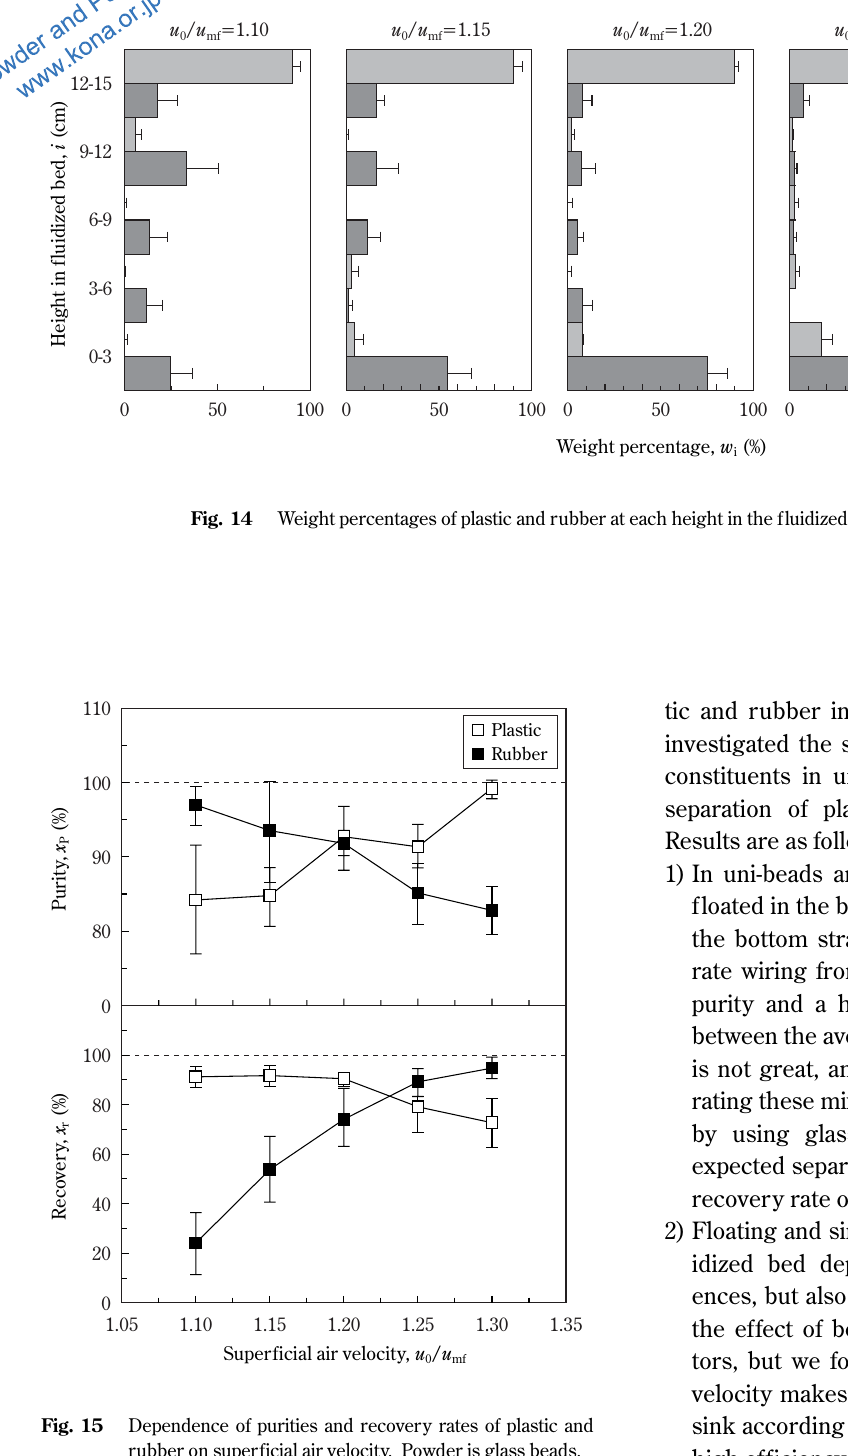
Fig. 15 Dependence of purities and recovery rates of plastic and rubber on superficial air velocity. Powder is glass beads.